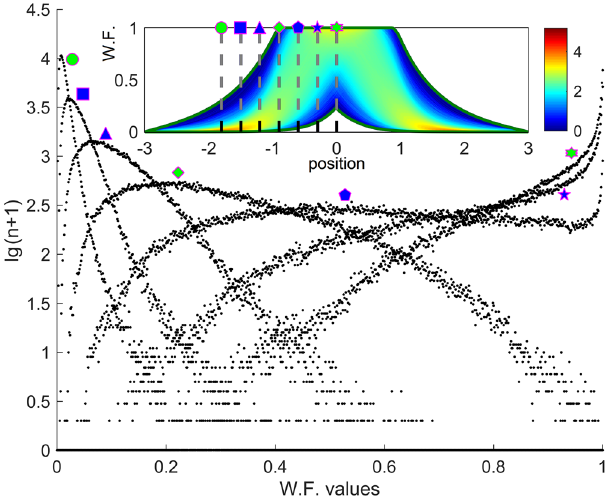
Figure 2. Logarithmic probability of occurrence of the WF possible values, at several chosen positions, for all 151 k samples in DS1. The inset encodes the same type of information in color